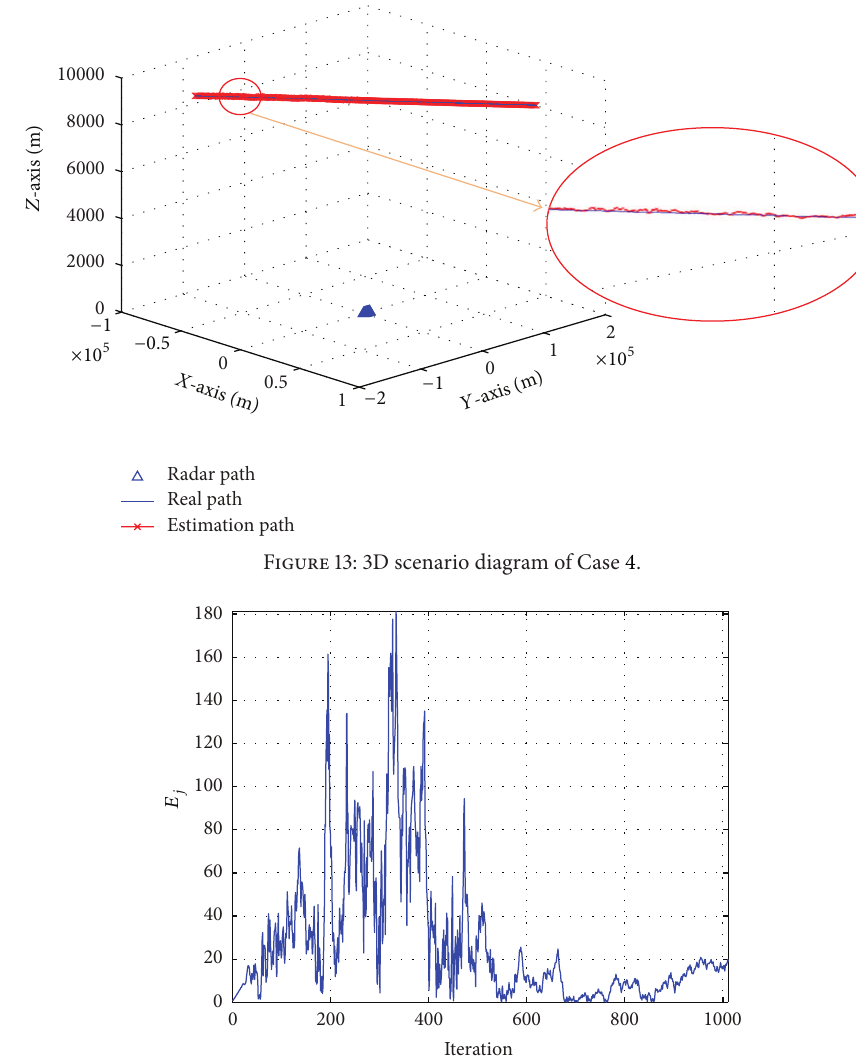
Figure 14: Tracking accuracy of AEKF for straight flight target.